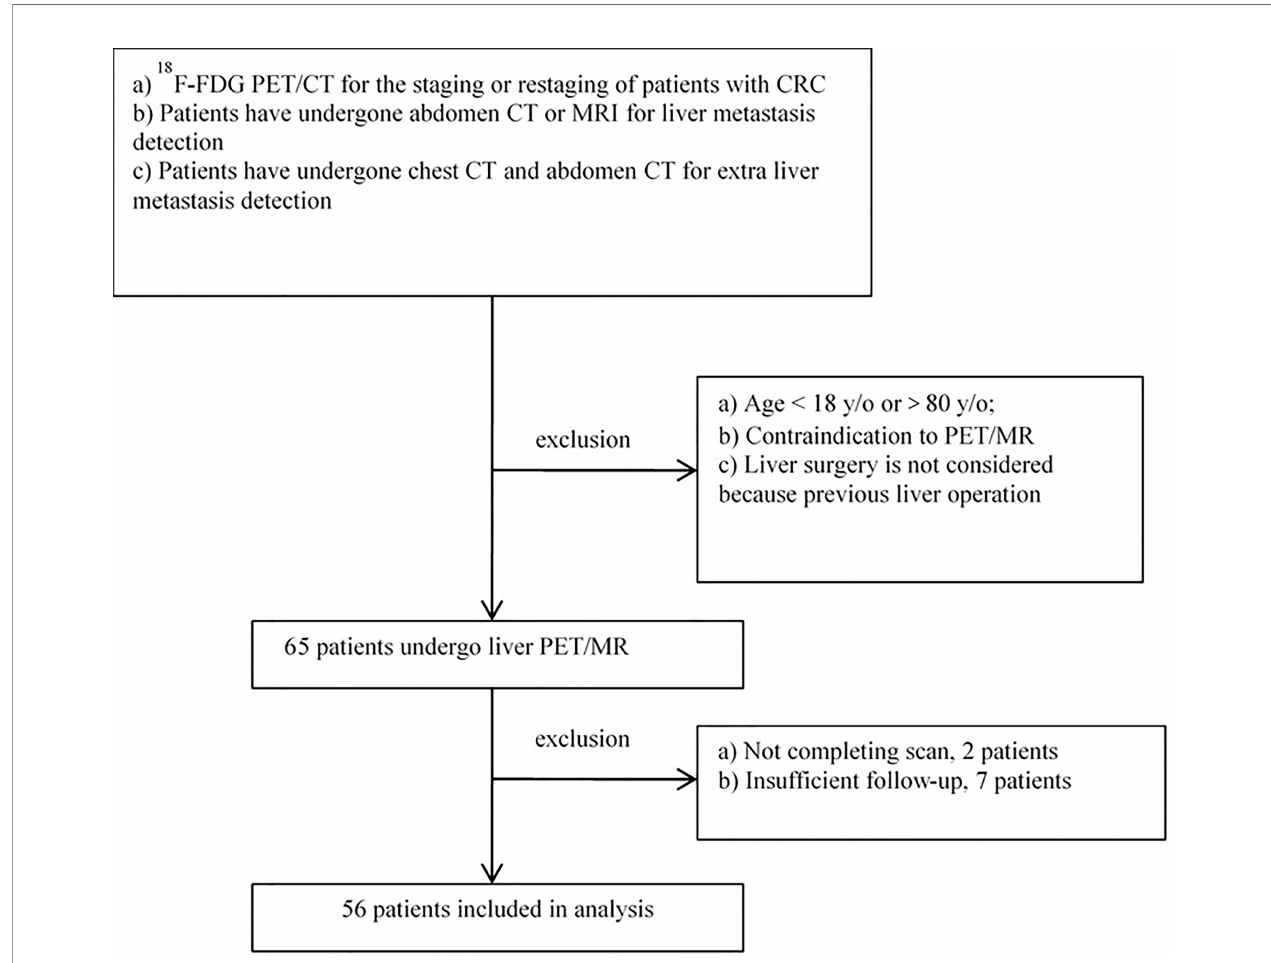
FIGURE 1 | The schematic of enrollment and exclusion